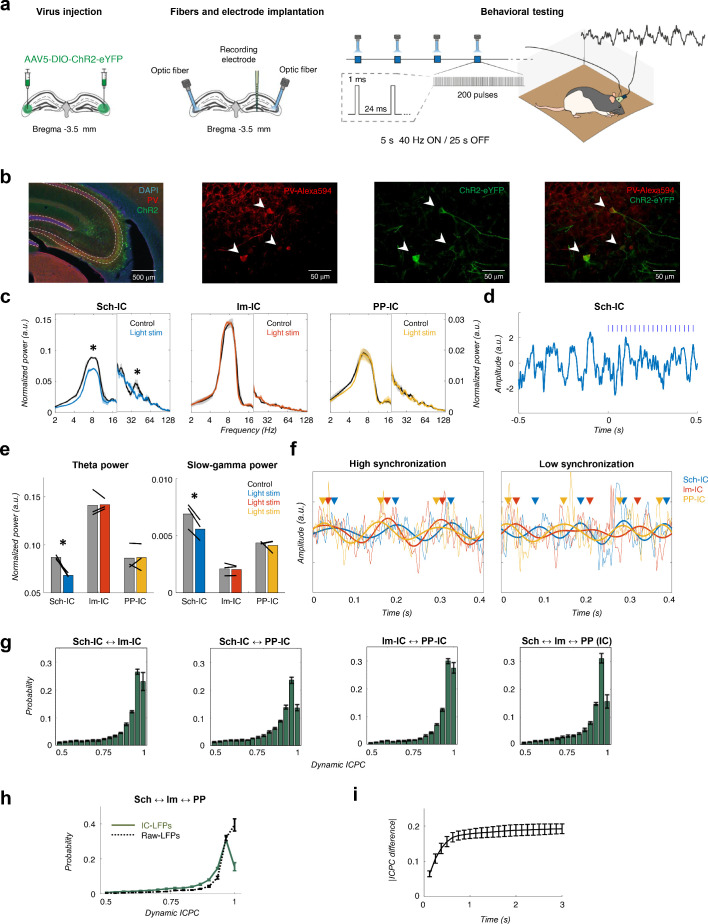
Different theta frameworks coexist in the dorsal hippocampus.(a) Schematic representation of virus injections (left), implantation of optic fibers and multichannel electrode (middle) and experimental setup and stimulation protocol (right). (b) Representative images of coronal sections confirming the specificity of ChR2 infection in PV interneurons in dorsal CA3. Left, low magnification image showing overlapped DAPI staining (blue), PV+ immunostaining (red) and ChR2-eYFP expression (green). Right, higher magnification images from the CA3 region showing PV+ immunostaining (red), ChR2-eYFP expression (green) and their co-localization. White arrows point to double PV+ and eYFP+ interneurons. (c) Optogenetic manipulation of PV interneurons. Power spectra analysis (mean ± s.e.m.) of the IC-LFPs during light OFF (black traces) and light ON (colored traces) conditions. Blue light (470 nm) illumination reduced theta and slow-gamma power selectively in Sch-IC. Note different y-axis scales for low (<20 Hz) and high (>20 Hz) frequencies for visualization purposes. (d) Representative example of changes in theta rhythm in Sch-IC during stimulation. Blue lines represent light pulses. (e) Statistical comparison between theta (left) and slow-gamma power (right) in control (grey bars) and during light stimulation (color bars; *p<0.05, paired t-test, t = 7.88/7.34 for theta/gamma Sch-IC, N = 3). Black lines represent different subjects. (f) Traces of raw and theta-filtered IC-LFPs showing epochs with high (left) and low (right) phase locking between their rhythms. Triangles pointing to the peak of theta cycles in each IC-LFP (differentiated by colors as before) are used to highlight variability in phase differences. (g) Distribution of ICPC values per theta cycle between pairs of components or with the three IC-LFPs simultaneously (mean ± s.e.m). (h) Distribution of ICPC values between the three IC-LFPs (green lines) and between the raw LFPs. (i) Dynamics of ICPC changes. The y axis represents the average ICPC differences in absolute values between two cycles, and the x axis represents the time difference between their occurrences. Consecutive cycles demonstrate more similar ICPC values than those separated in time up to 0.75 s.